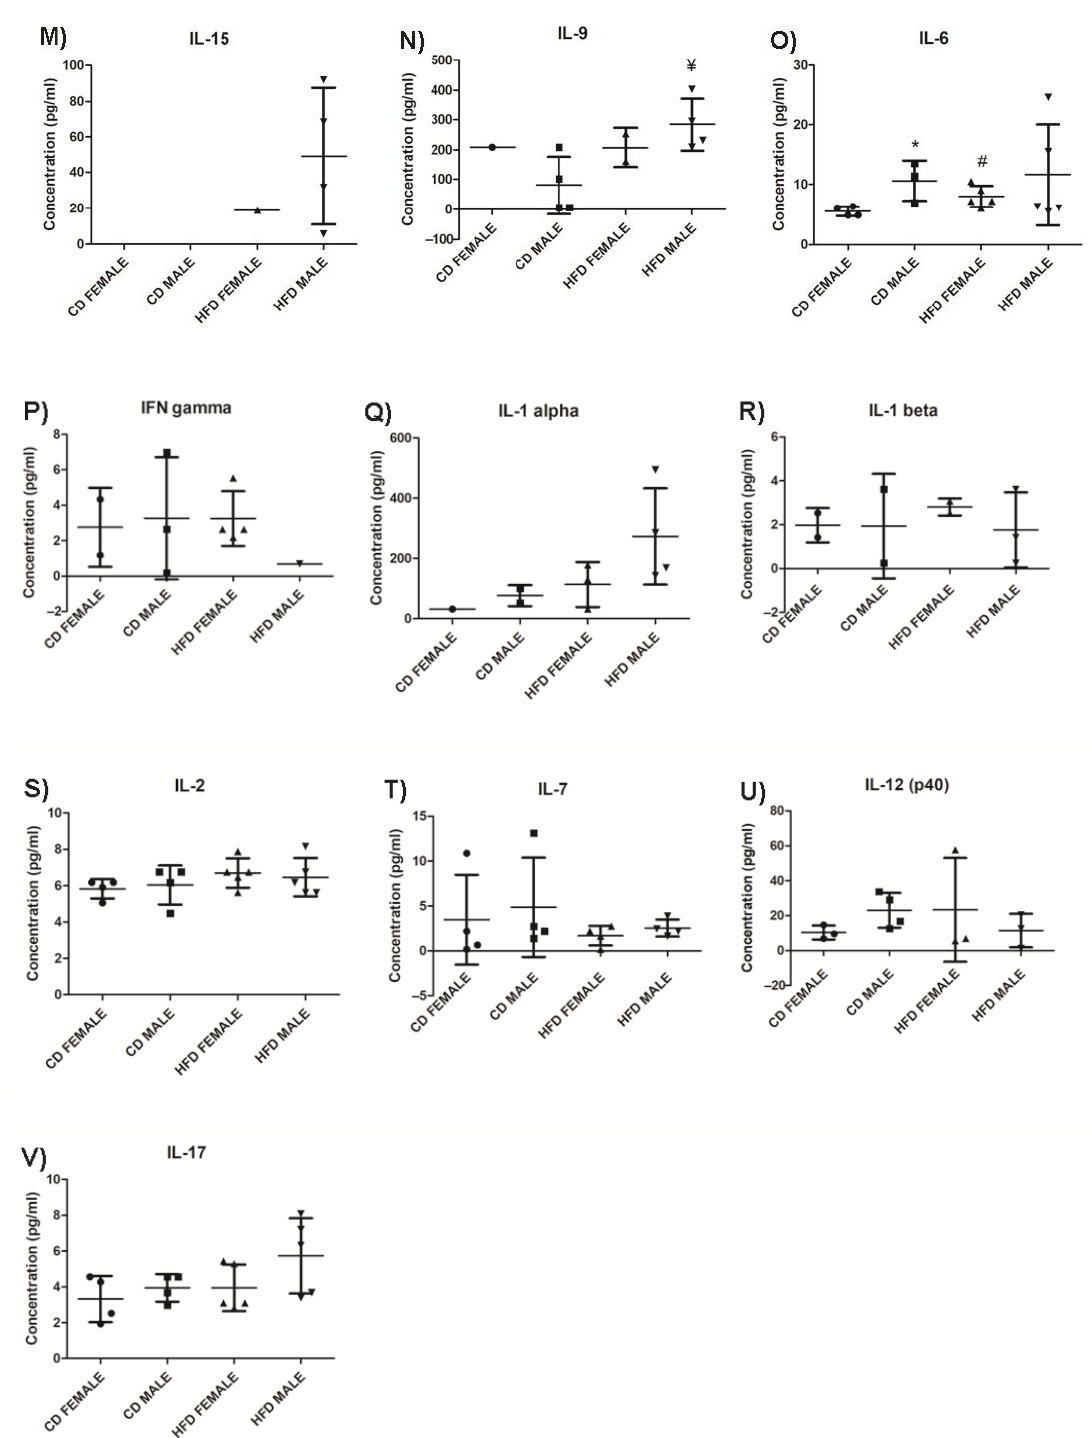
Figure 11. Chemokines, anti-inflammatory and pro-inflammatory cytokines levels in HFD and CD animals. MCP-1, ( A ); MIP-2, ( B ); IP10, ( C ); RANTES, ( D ); KC, ( E ); MIP-1 α , ( F ); MIP-1 β , ( G ); IL-10, ( H ); G-CSF, ( I ); IL-5, ( J ); IL-4, ( K ); IL-13, ( L ); IL-15, ( M ); IL-9, ( N ); IL-6, ( O ); IFN- γ , ( P ); IL-1 α , ( Q ); IL-1 β , ( R ); IL-2, ( S ); IL-7, ( T ); IL-12 (p40), ( U ); and IL-17, ( V ). The graphs display the cytokines measured in CD females, CD males, HFD females and HFD males. * Significant difference between the CD females and CD males, p < 0.05. # Significant difference between CD female and HFD female, p < 0.05. ¥ Significant difference between CD male and HFD male p < 0.05. € Significant difference between HFD female and HFD male, p < 0.05. Mean ± SD. Black circle, triangle and square represent individual data points in the different categories CD females, CD males, HFD females and HFD males on the